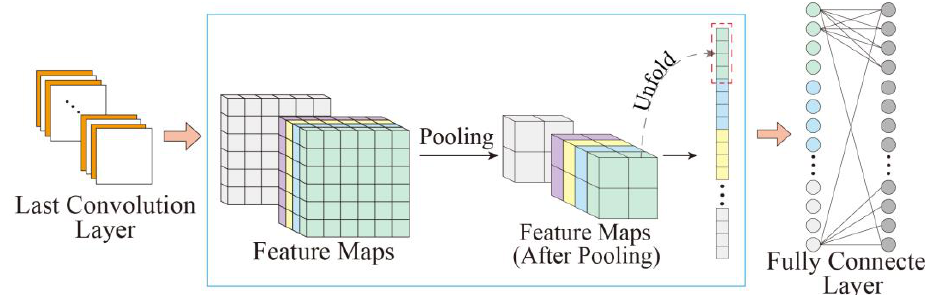
bedding the second-order information extraction process into CNN and deriving its for- ward and back propagation. The process of the second-order pooling was shown in Figure 9. The whole process can be divided into the following six steps. Figure 8. Process of integrating feature maps of traditional pooling methods. Figure 8. Process of integrating feature maps of traditional pooling methods.